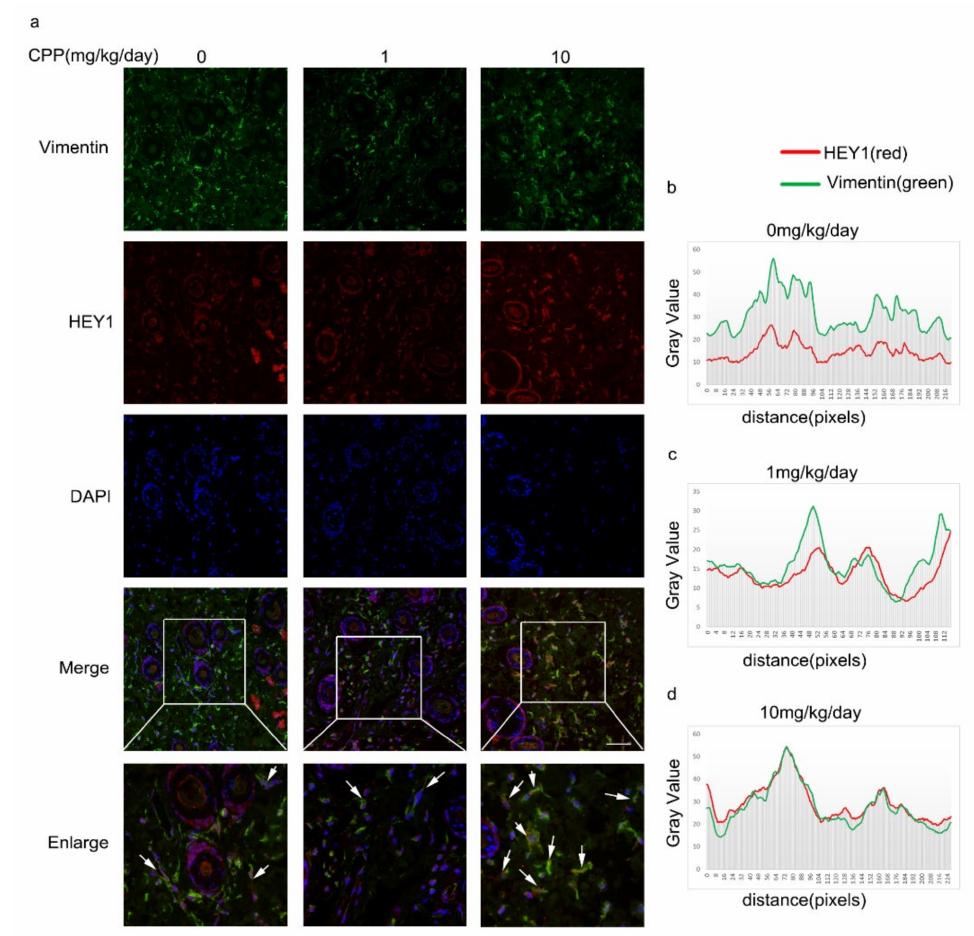
Figure 9. CPP increased the protein levels of HEY1 in HDFs in vivo. ( a ) After two weeks of continuous intraperitoneal injection of mice with different concentrations of 1 mg/kg/day and 10 mg/kg/day, of CPP and PBS, respectively, mouse dorsal skin was extracted, paraffin sections were performed, and the protein levels of HEY1 and Vimentin were detected by immunofluorescence. White arrows indicate cells expressing both Vimentin and HEY1. Scale bars: 100 µ m. ( b – d ) ImageJ analysis of co-localization of Vimentin and